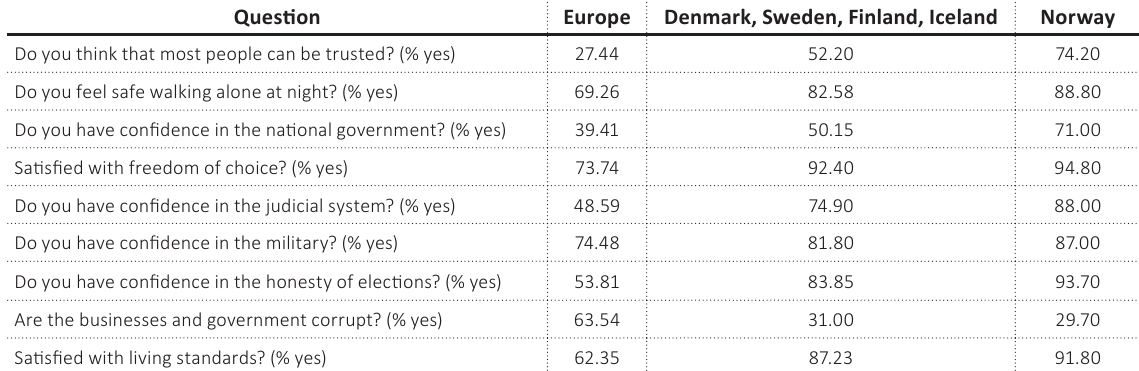
Source: The Legatum Institute